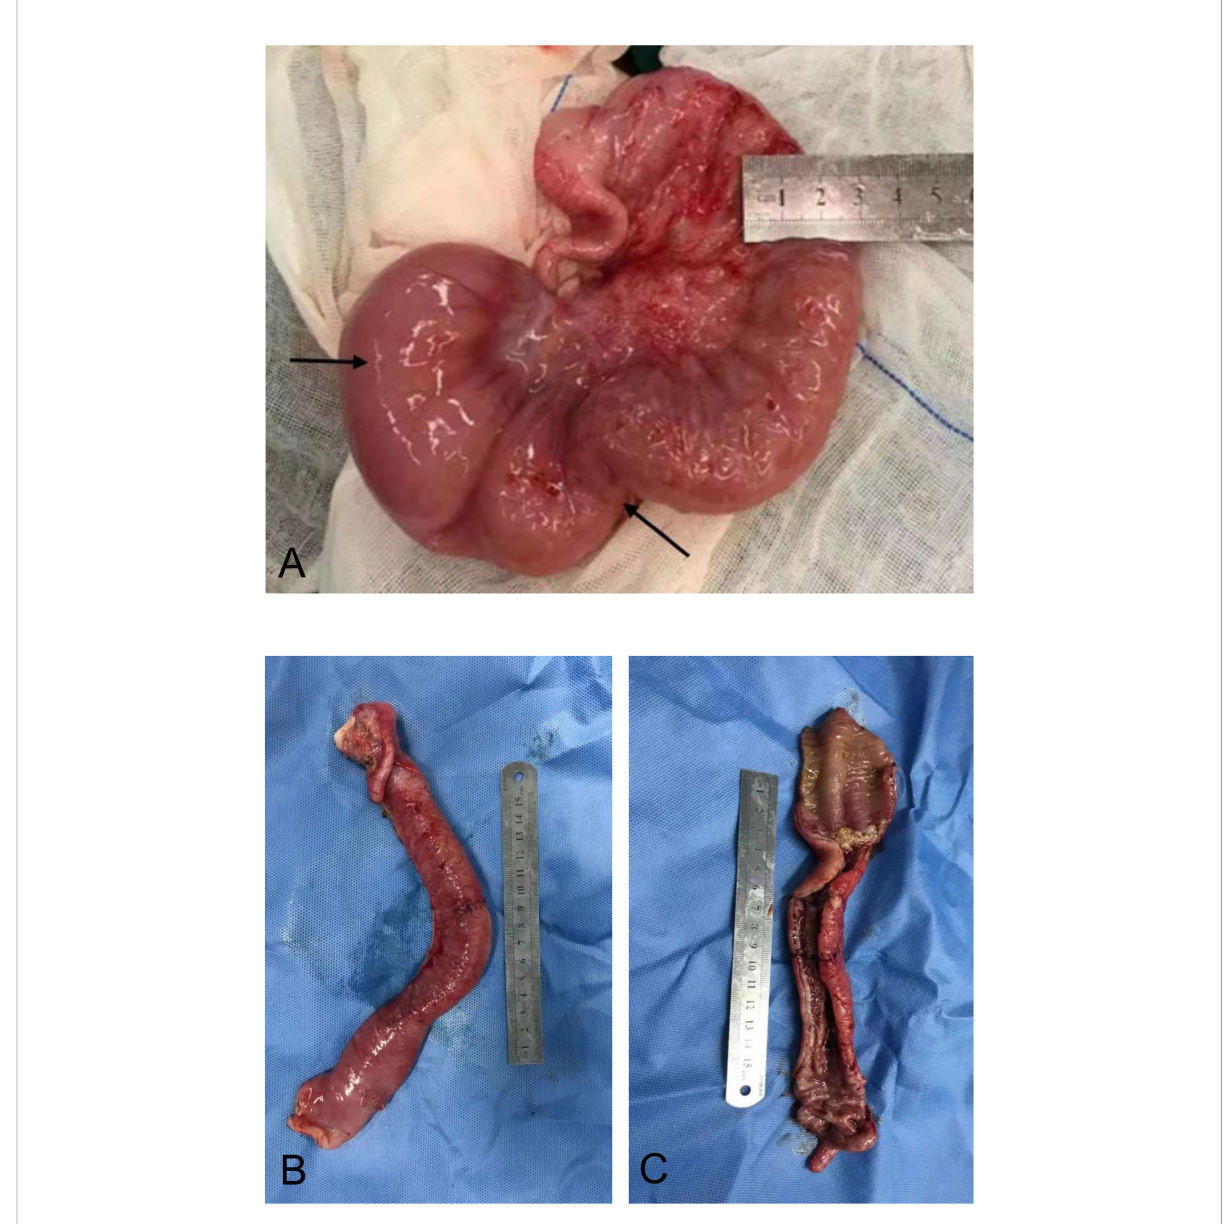
FIGURE 3 Surgical resection of the affected small intestine. (A) Small intestine wall thickening, edema, and stenosis. (B) Stiffness of the affected small intestine. (C) Reduction in the mucosal